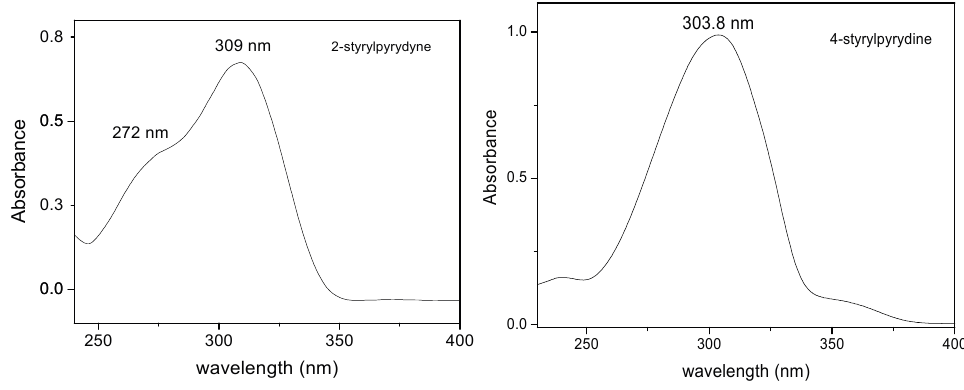
Figure 4. Absorption spectra of 2-styrylpyridine and 4-styrylpyridine in methanol.